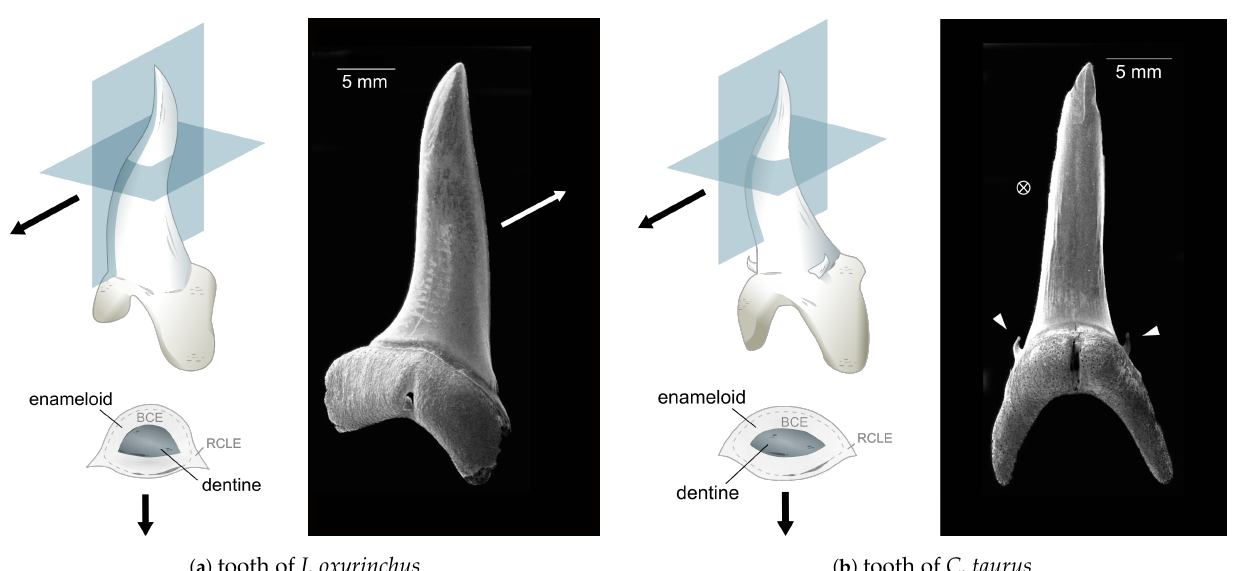
Figure 2. Tooth morphology of the two studied species. Both species have slender, dagger-like teeth without serrated edges. The teeth are curved slightly to improve the grip on prey. Sketches on the left show the tooth and its transversal cross-section. Arrows indicate the facial direction. The shaded planes correspond to the section planes used in imaging. The enameloid cover consists of inner and outer enameloid, marked in the cross-section with BCE and RCLE, respectively. I. oxyrinchus teeth ( a ) are monocuspid while C. taurus teeth ( b ) are tricuspid with a large main cusp and small outer cusplets indicated by white arrowheads. The I. oxyrinchus tooth ( a ) exhibits a small amount of wear on the lingual side of the tip. The C. taurus tooth depicted in ( b ) is fractured at the